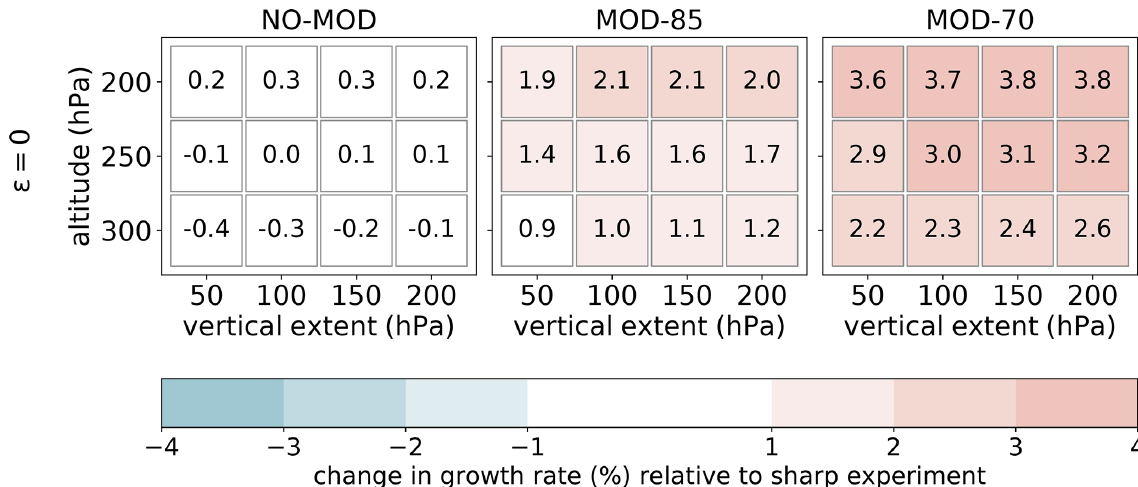
Figure 8. Change in growth rate (shading and numbers) for various smooth experiments relative to the CTL experiment with the same discontinuous profiles of λ and S from Fig. 6 for no latent heating ( ε = 0). See text for further details.